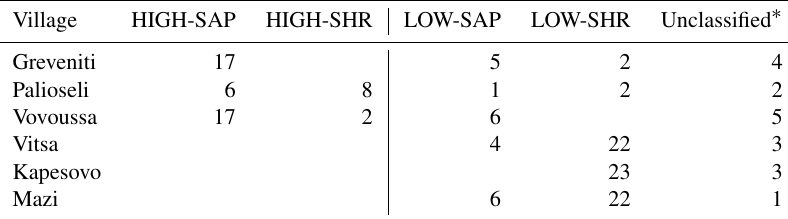
Table H2. This table shows the distribution across sites of the plots classified into the final four woody plant